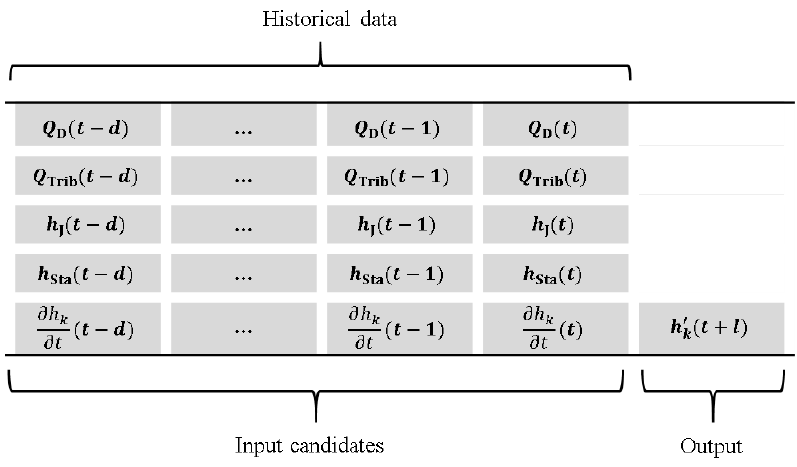
Figure 7. Input candidates and output for ANN1.